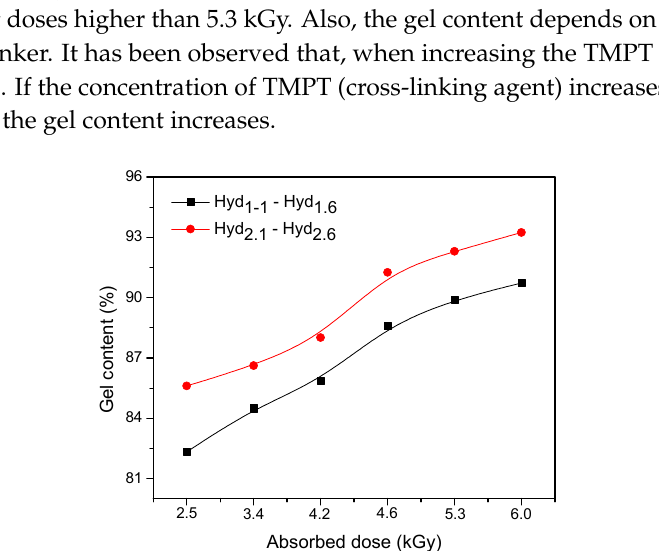
Figure 1. The effect of the absorbed dose on the gel fraction of hydrogels.